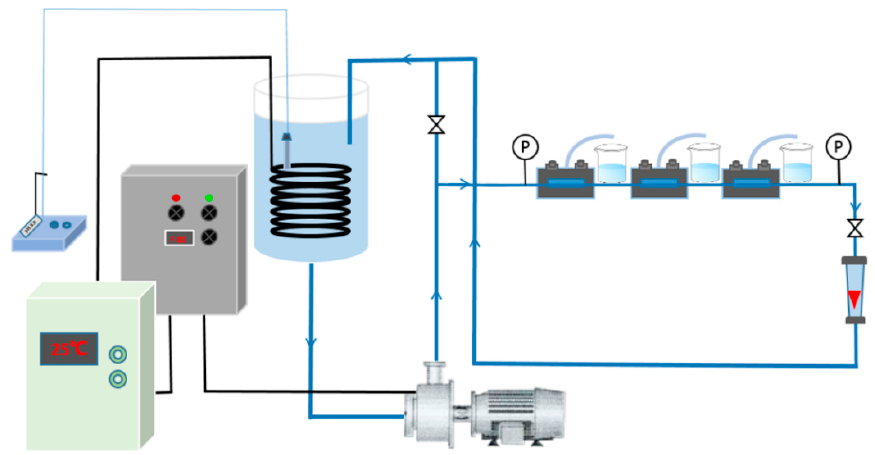
Figure 2. Schematic diagram of the experimental apparatus used to evaluate the permselectivity of the fabricated RO membranes.